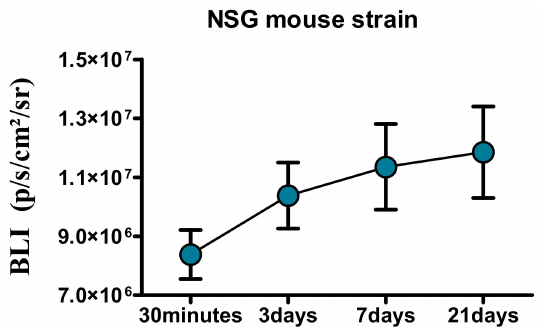
Figure A5. Haemolysis test revealing the hemocompatibility of Cis-Fe-PEI.